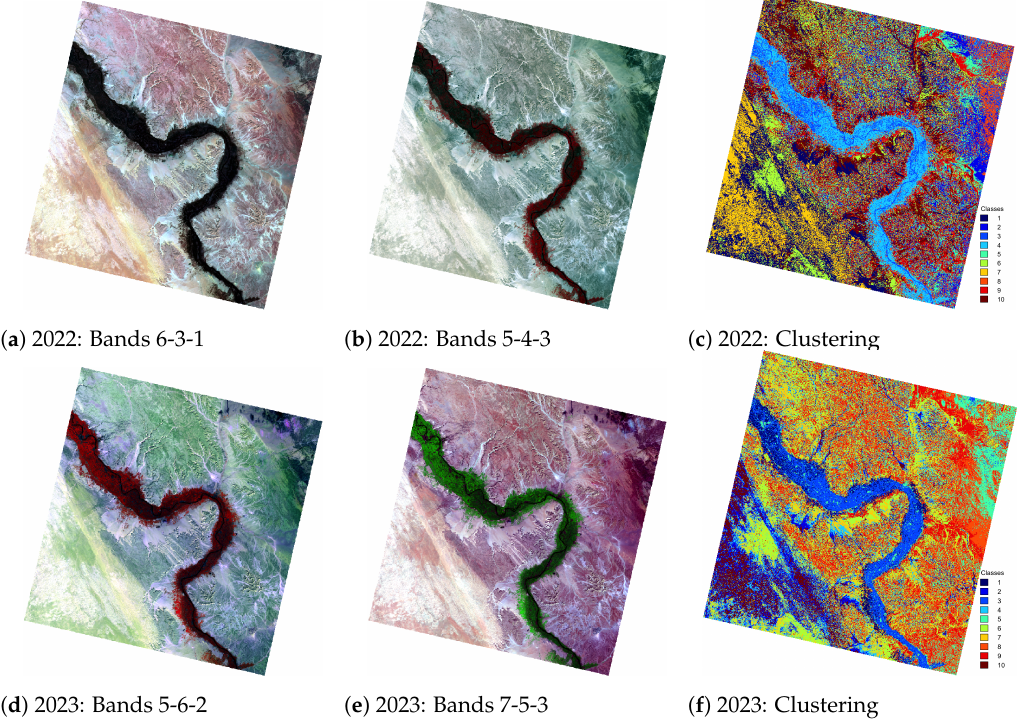
Figure 9. Qena Bend of the Nile River: false color composites and clustering of the Landsat 8-9 OLI/TIRS images: ( a ) 2022 RGB in 6-3-1 Bands, ( b ) 2022 RGB in 5-4-3 Bands, ( c ) 2022 unsupervised classification, ( d ) 2023 RGB in 5-6-2 Bands, ( e ) 2023 RGB in 7-5-3 Bands, ( f ) 2023 RGB: